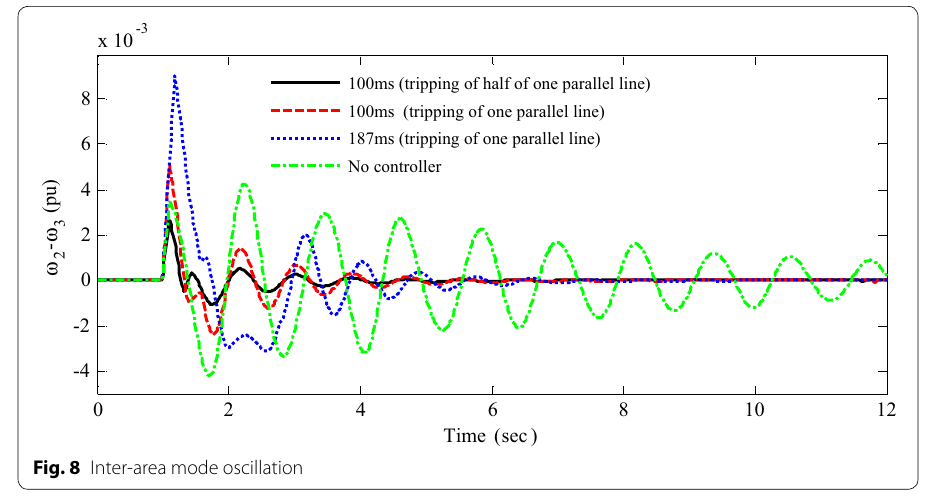
Fig. 8 Inter-area mode oscillation